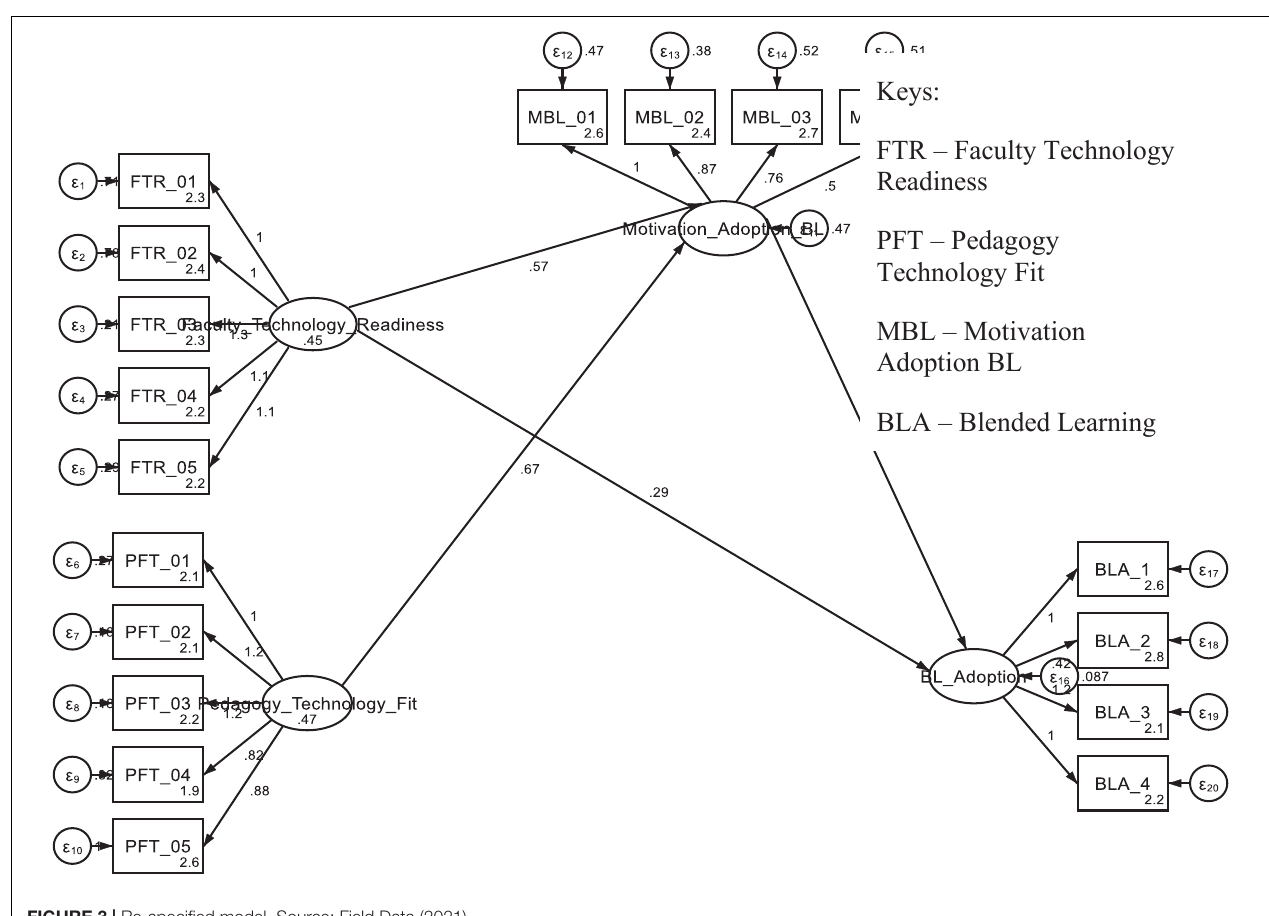
FIGURE 3 | Re-specified model. Source: Field Data